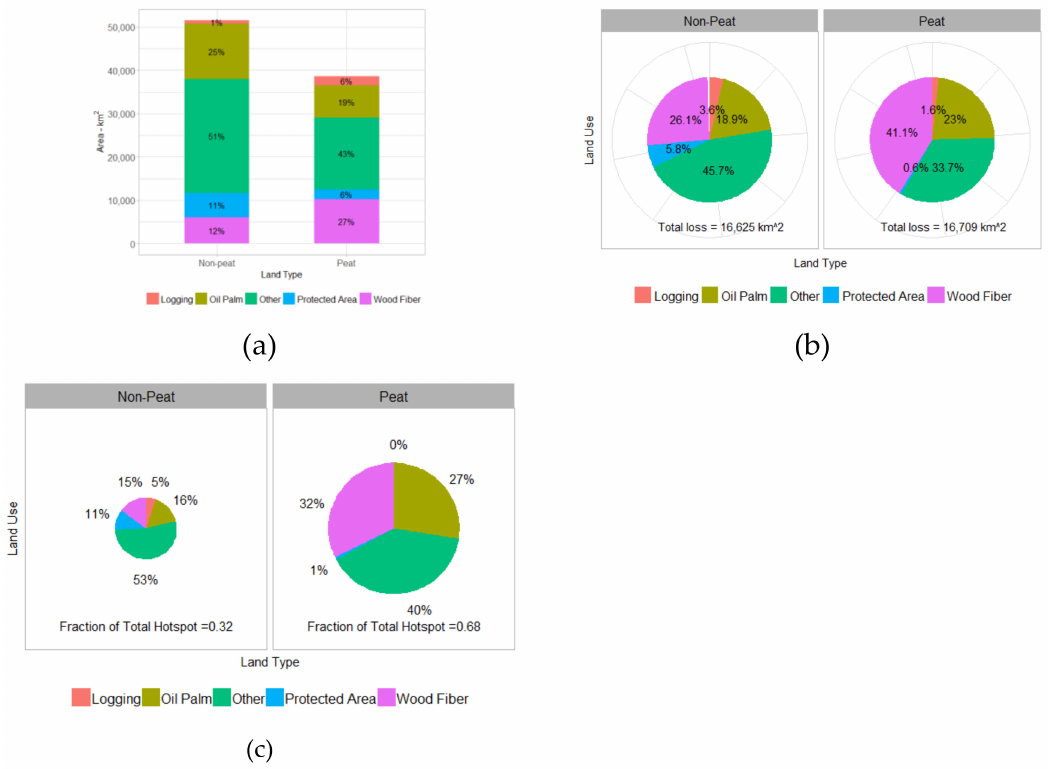
Figure 5. Land area, forest loss, and hot spots by land-use in peat and non-peat regions ( a ) Area; ( b ) Proportion of tree cover loss; ( c ) Proportion of hotspot number.